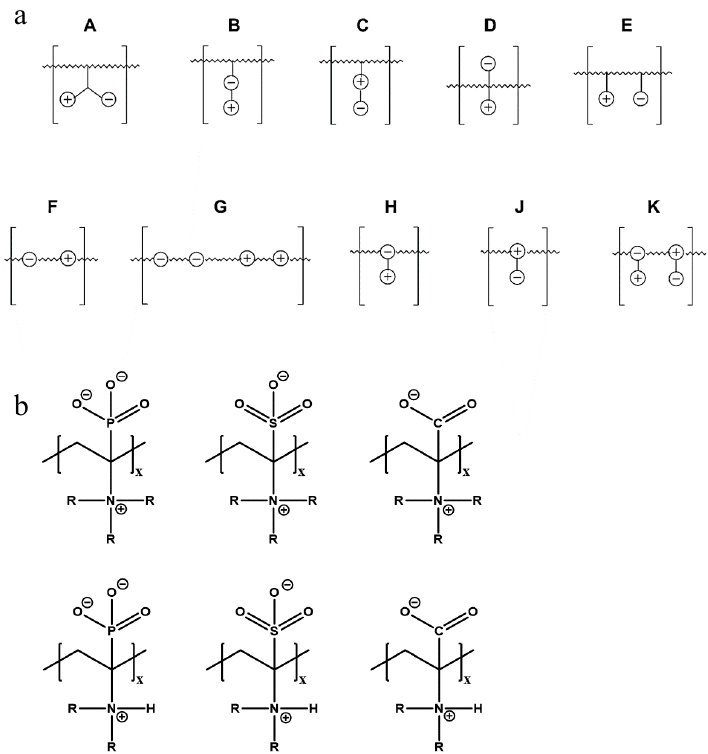
Figure 2. ( a ) Different arrangements of the functional groups in polyzwitterionic chains, reprinted from [101], and ( b ) commonly employed zwitterionic repeating units in polymeric materials.